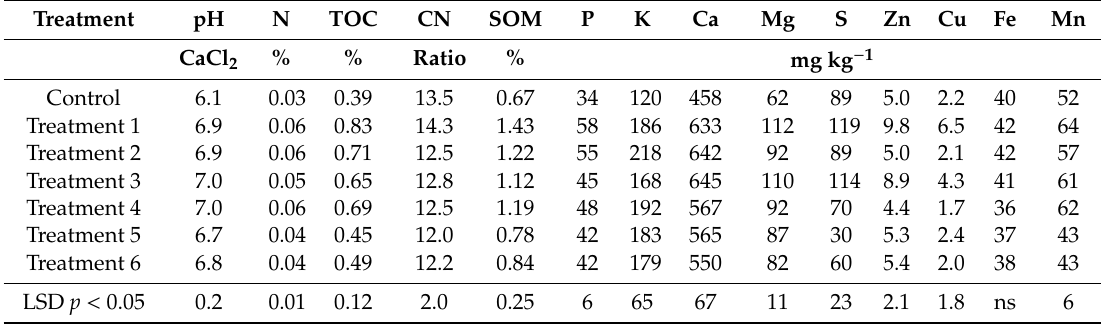
Table 4. E ff ect of poultry litter manure, biochar, and conventional fertilizers on soil nutrient concentrations at